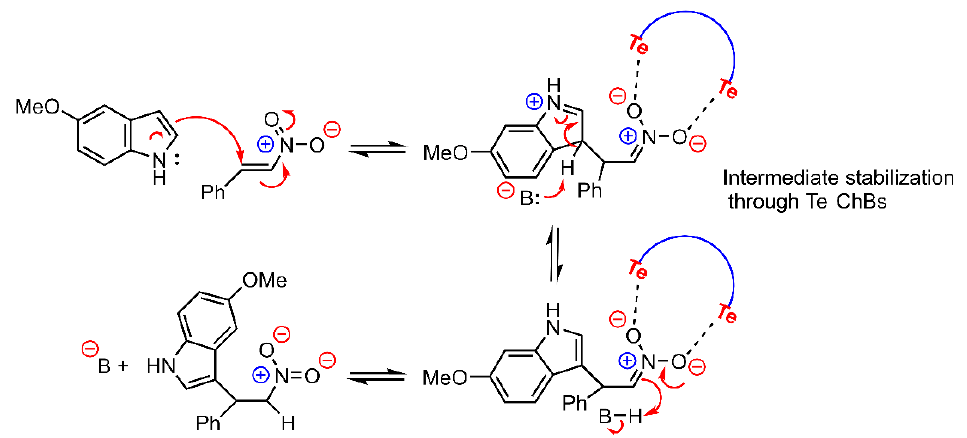
Figure 18. Schematic representation of the proposed reaction pathway for the nitro Michael reaction catalyzed by compound 26 with a plausible stabilization of the reaction intermediate through two simultaneous ChBs.